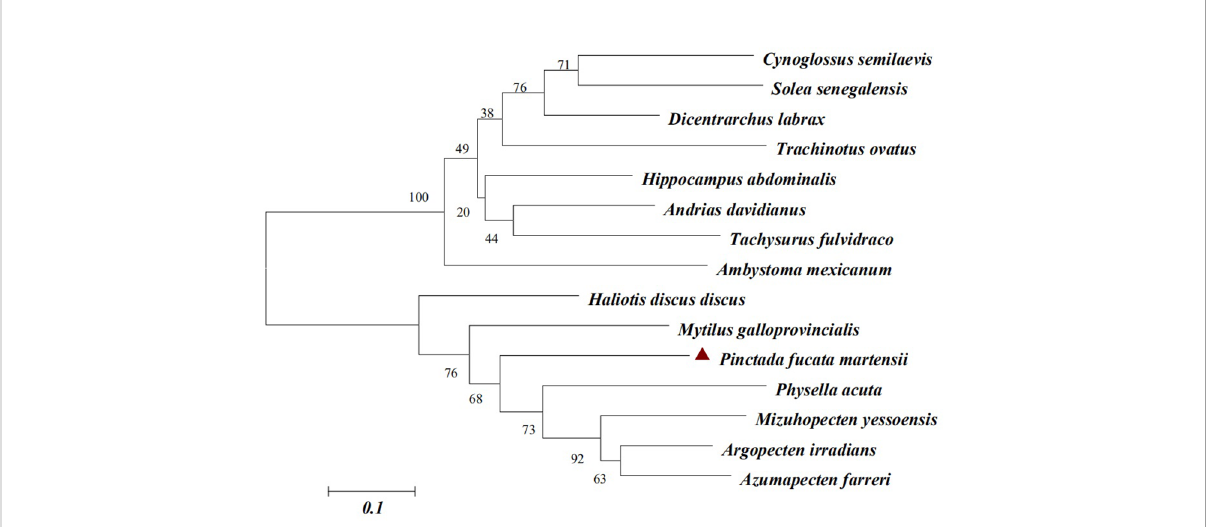
FIGURE 3 PmlysG Phylogenetic tree construction (Neighbor-joining method). GenBank accession numbers for some species are as follows: Cynoglossus semilaevis (AEQ19605.1), Solea senegalensi s (CCA95109.1), Dicentrarchus labrax (AIE45885.1), Tachysurus fulvidraco (ALD84262.1), Ambystoma